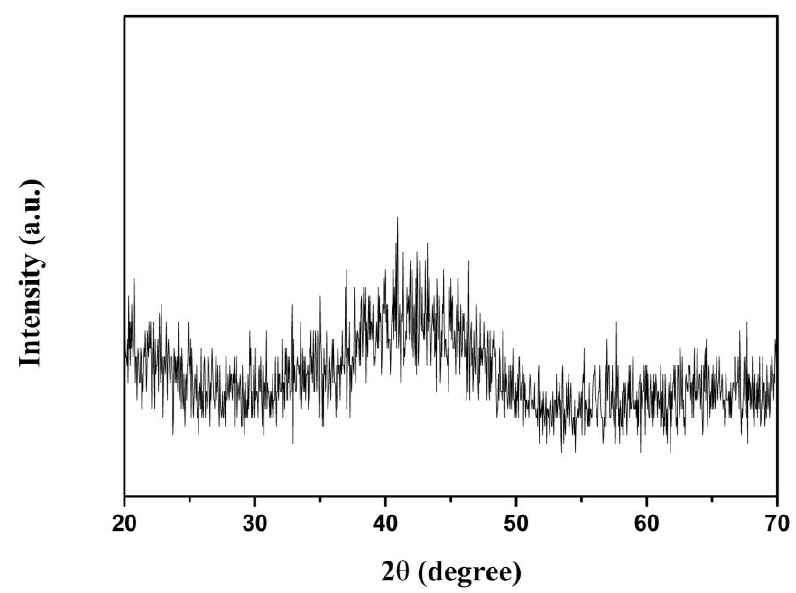
Figure 1. X-ray diffraction pattern of the (Nd 0 . 525 Pr 0 . 175 Ce 0 . 3 ) 9 Fe 64 . 5 Co 3 Cu 0 . 5 Ti 1 B 22 as-spun ribbons. The DSC curves of the (Nd 0 . 525 Pr 0 . 175 Ce 0 . 3 ) 9 Fe 64 . 5 Co 3 Cu 0 . 5 Ti 1 B 22 as-spun ribbons at a